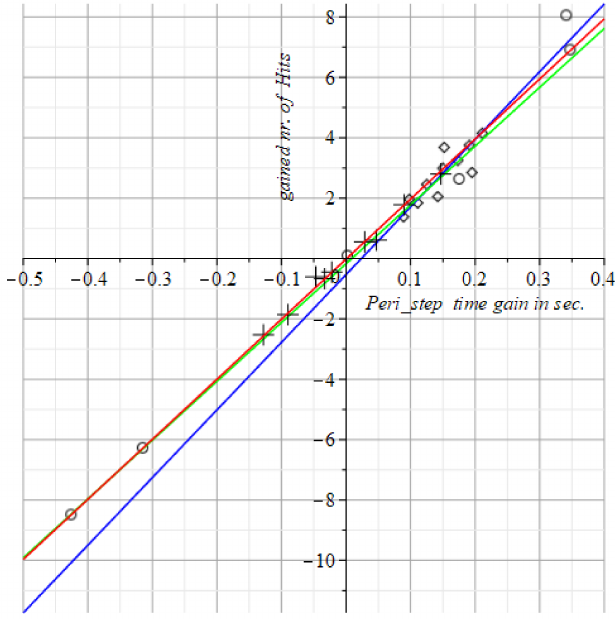
Figure 10. The results of the peripheral step test. The results discriminate between the motor group and the visuo-spatial-motor group: Three subjects in the motor group improved performance, one remained neutral (=the circle at the origin) and two scored less than prior to the motor intervention. The control group also shows a mixed picture. In the visuo-spatial-motor group all subjects improved performance. Circles and green line: Motor group, T 1 = − 1.73 ( ± 0.30) + 19.5 ( ± 0.99) T 0 . Rhombus pts., blue: Visuo-spatial-motor group, T 1 = − 0.52 ( ± 0.67) + 22.4 ( ± 2.4) T 0 . Plus signs, red line: Control group, T 1 = − 0.02 ( ± 0.06) + 19.9 ( ± 0.67) T 0